Question: What does this figure show? Answer in one sentence.
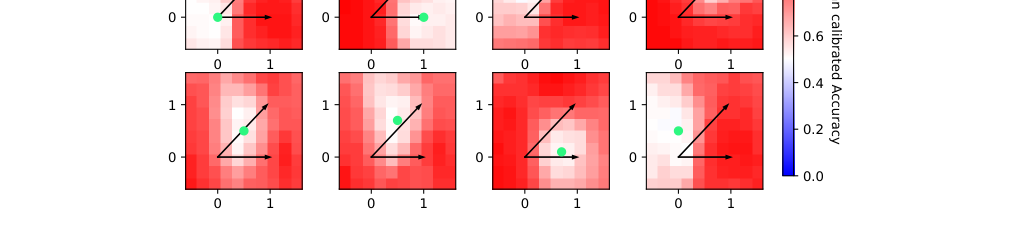
Answer: The plots show the mean median-calibrated accuracy when one pair of binding ID, v0, is fixed at the green circle, and the other, v1, is varied across the grid. The binding IDs b(0), b(1), and b(2) are shown as the origin of the arrows, the end of the horizontal arrow, and the end of the diagonal arrow respectively. We use LLaMA-13b for computational reasons.